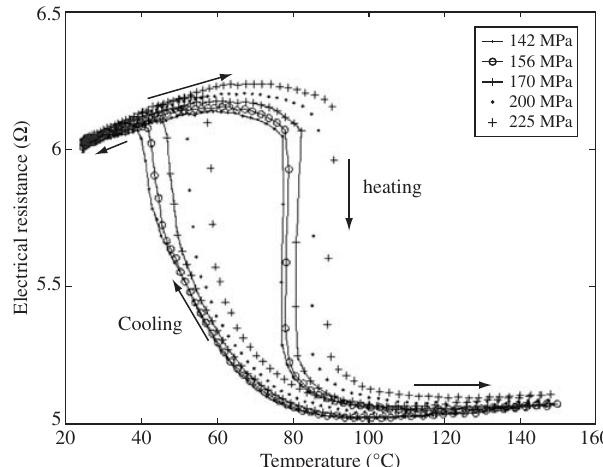
Figure 7. Transformation temperatures as a function of applied load on the SMA wire.